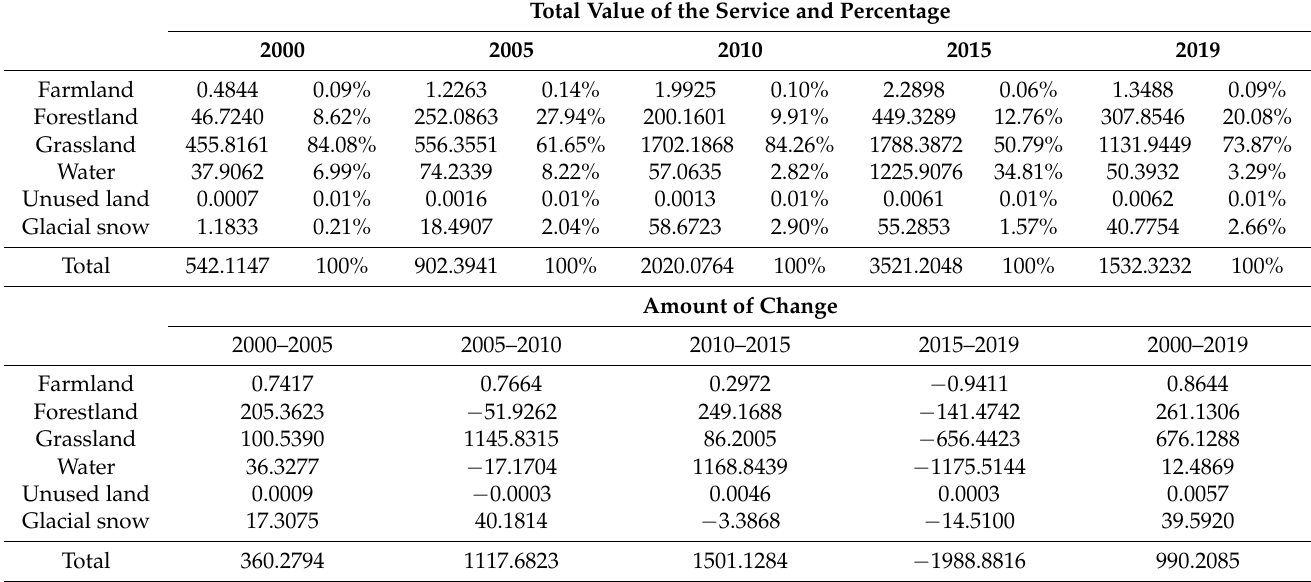
Table 6. The total value and proportion of ecosystem services of each land type in Qilian Mountain National Park (Gansu Area) and the corresponding